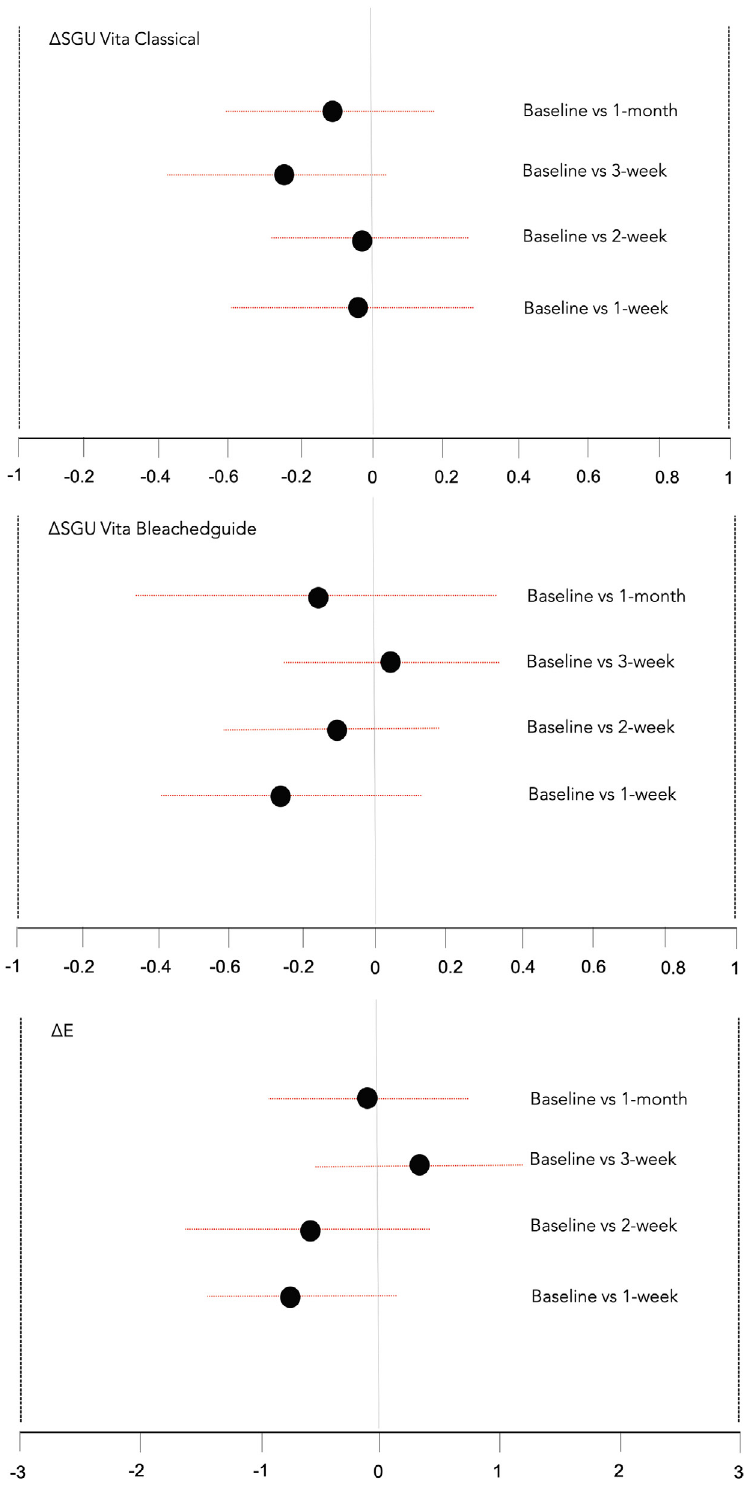
Figure 2- Mean differences of color change measured with different instruments between non-reservoir and reservoir groups at the different assessment times. Horizontal bars indicate two-sided 90% confidence interval (CI) of the mean difference between treatment groups. The zone between the dashed lines indicates the equivalence